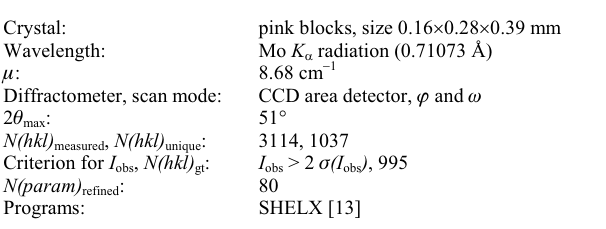
Table 1. Data collection and